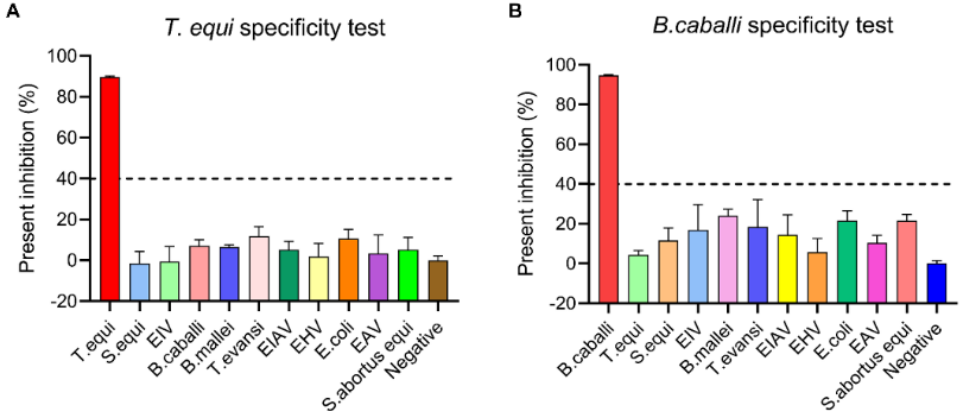
Figure 3. Analysis of the specificity of the novel cELISA. Cross-reaction of the novel cELISA to T. equi ( A ) or B. caballi ( B ). Sera positive for other pathogens, including EIAV, EAV, EHV-4, EIV, B. caballi , B. mallei , T. equi T. evansi , E. coli , S. equi , S. abortus equi, and a negative sample, were tested with the novel cELISA at the same time.